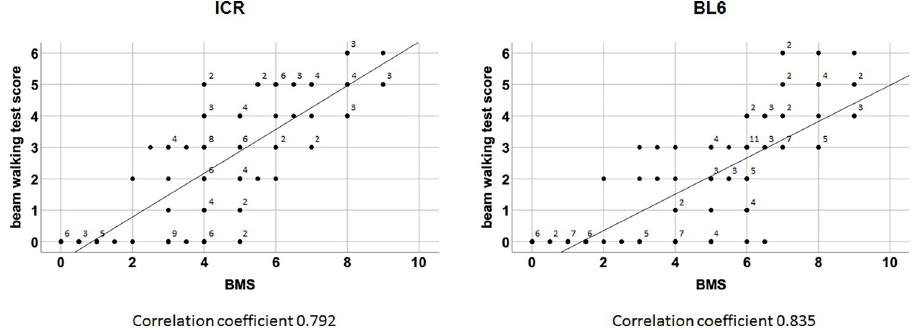
Fig 7. Correlation between the beam walking test score and BMS score. The scores of BMS (x-axis) and the beam walking test (y-axis) from mice 1 day and 1, 2, 3 and 4 weeks after both mild and severe SCI were plotted in the graph. When there are multiple mice showing same beam walking score and BMS score, the corresponding dots were labeled with the numbers of mice. Spearman’s rank correlation coefficient was calculated.